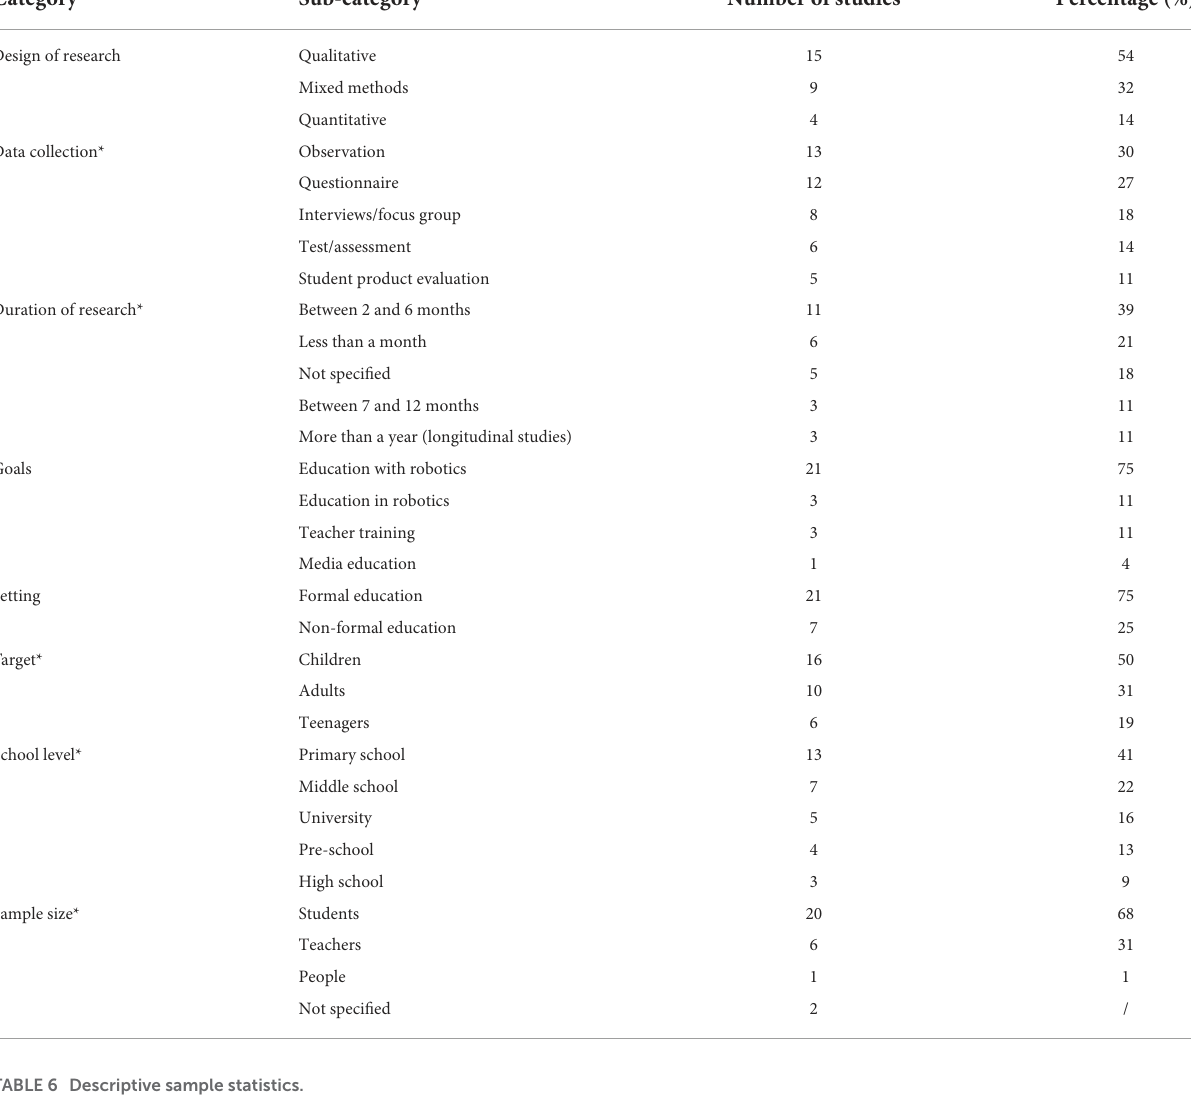
TABLE 5 Summary of research data.